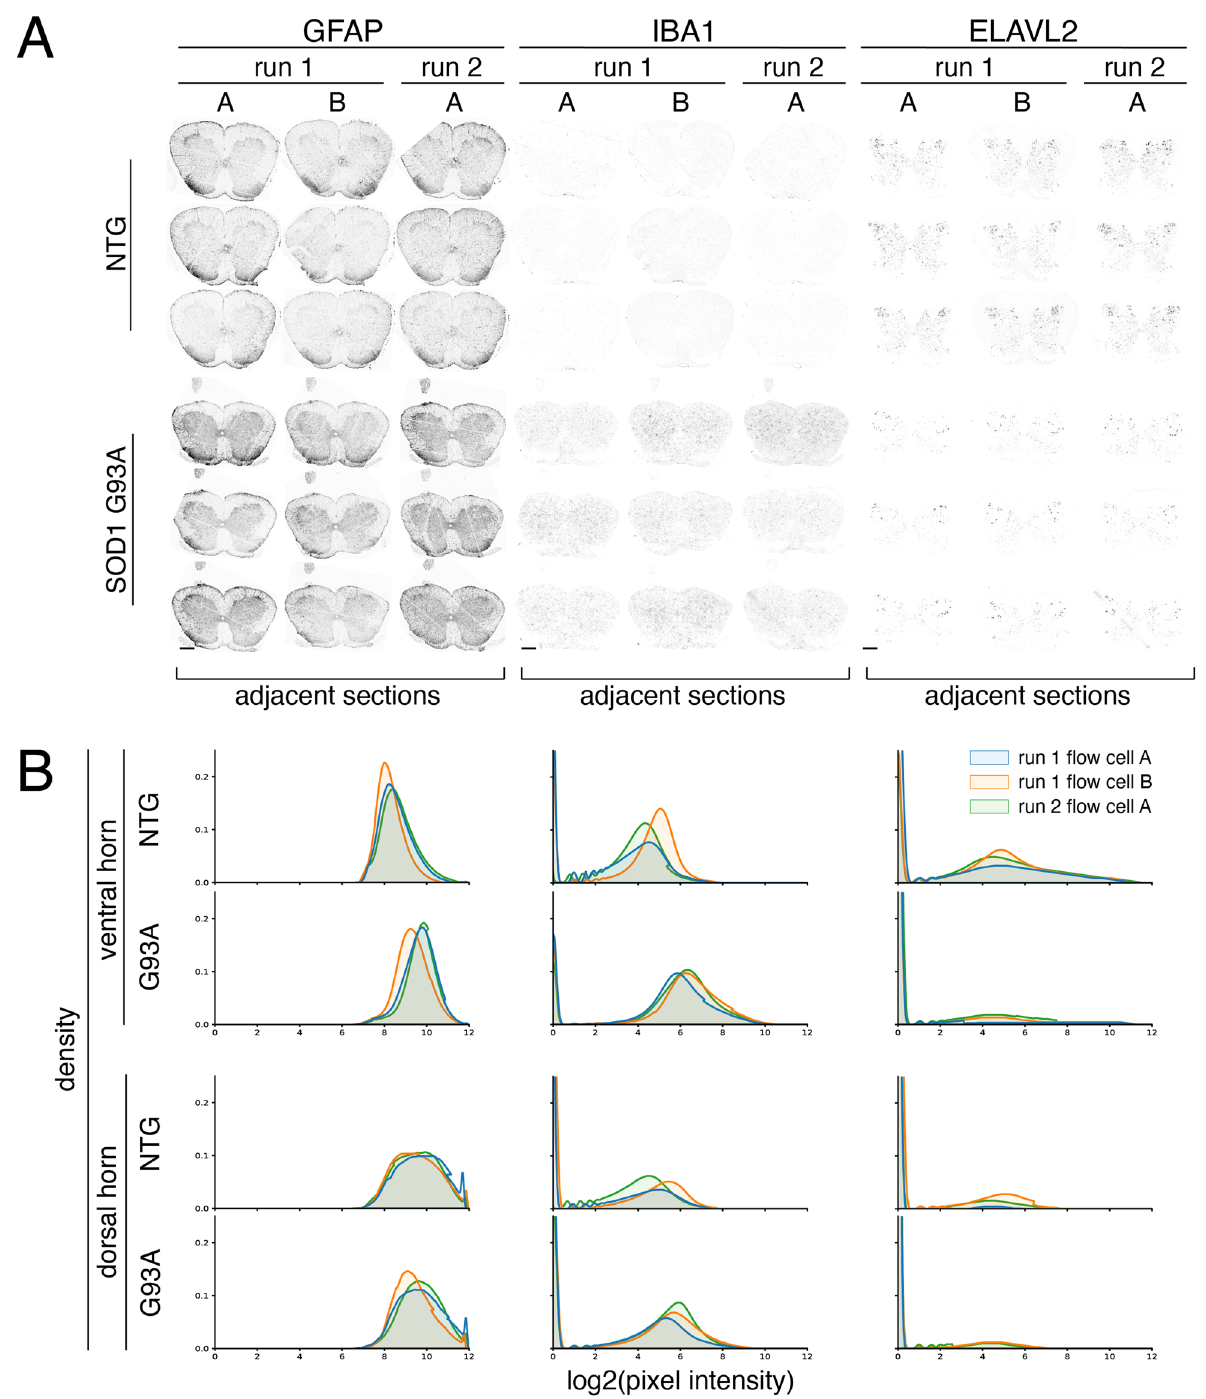
Figure 3. PySeq2500 automated 4i staining of adjacent spinal cord sections across flow cells and runs ( A ) Spinal cord sections from SOD1 G93A and nontransgenic animals stained for GFAP (astrocytes), IBA1 (microglia), and ELAVL2 (neurons) in two 4i cycles. Adjacent tissue sections from each animal were processed on flow cells run in parallel (run 1A and 1B) and across multiple experiments (run 1 and run 2). Scale bars represent 500 µm. ( B ) Histograms of signal intensity for each marker in manually annotated dorsal and ventral horn regions colored by experimental